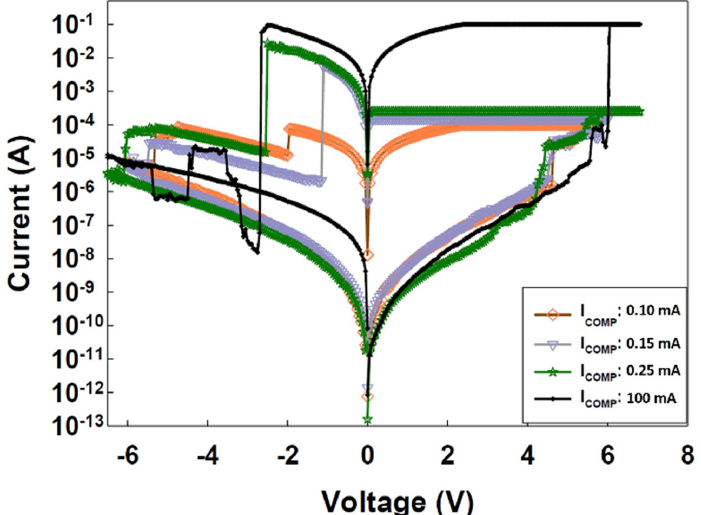
Figure 6. I-V characteristics of Au/Ni/SiO x N y /p + -Si memory device with various I COMP